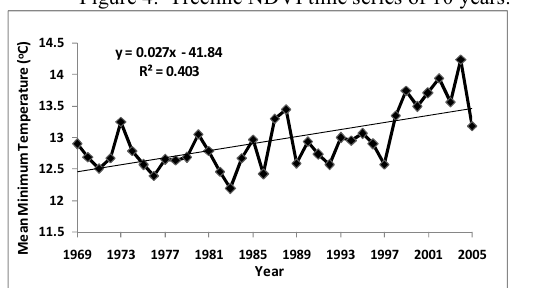
Figure 4. Treeline NDVI time series of 10 years.